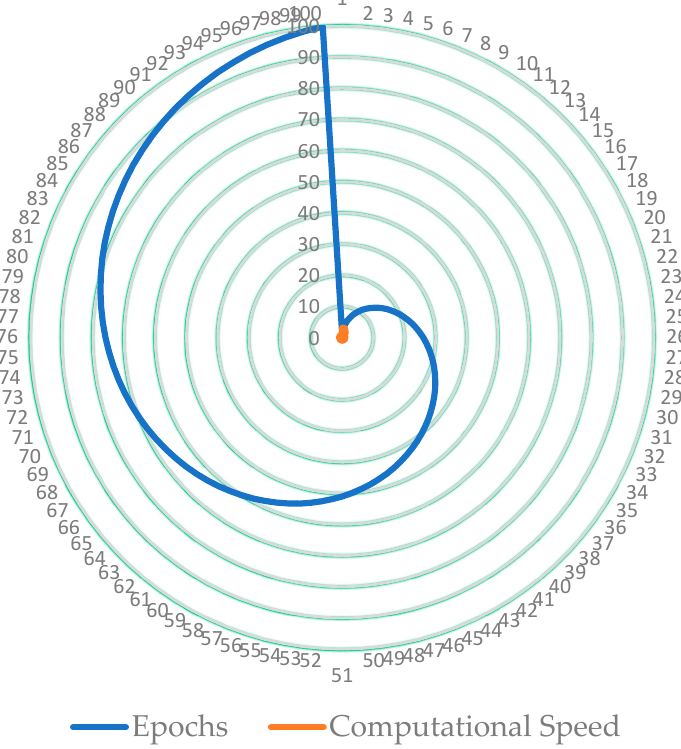
Figure 7. The computational speed of DBoTPM model for botnet prediction.